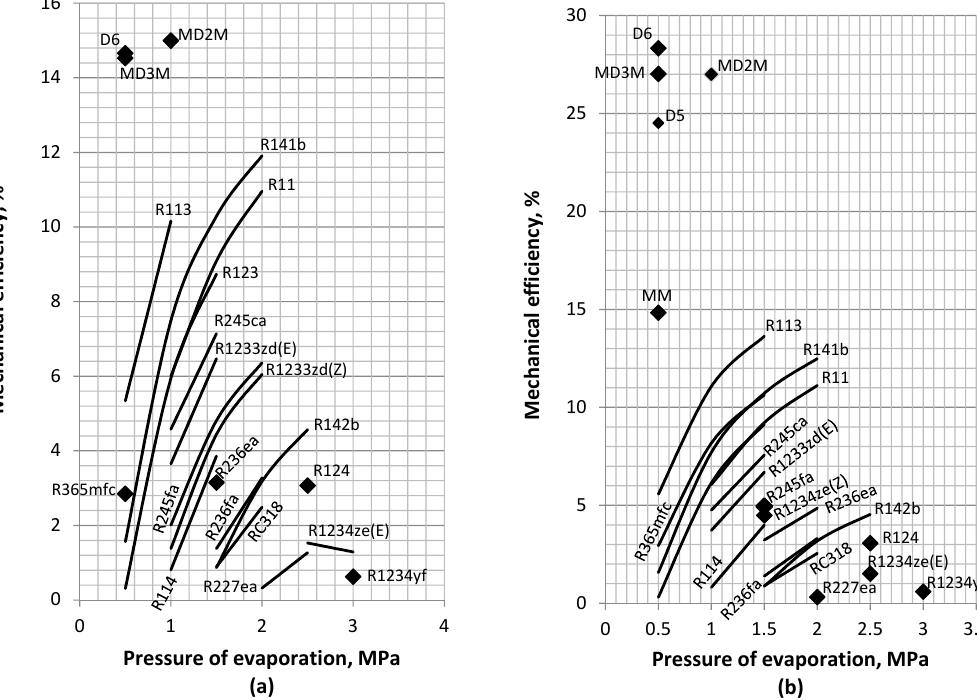
Figure 5. Effect of the evaporation pressure on the mechanical efficiency of the ORC cycle using refrigerants and siloxanes without regeneration ( a ) and with regeneration ( b ).